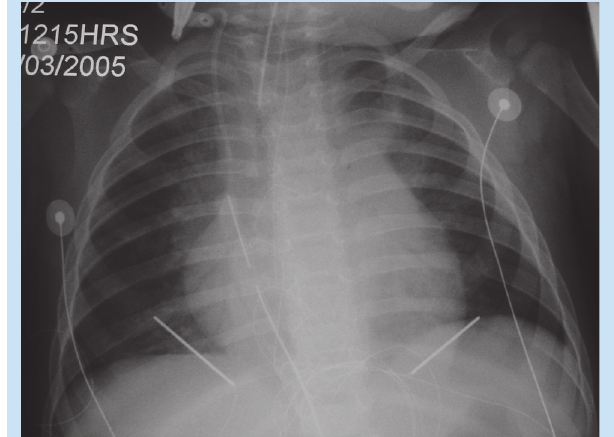
Fig. 21. Cardiac failure. The predominant distribution of airspace disease in this patient with cardiac failure is characteristically bilateral peri-hilar. There are features in keeping with cardiac surgery on the radiograph including a mediastinal drain and pacing leads. Looking at the lines and tubes therefore is important for distinguishing causes of airspace disease.